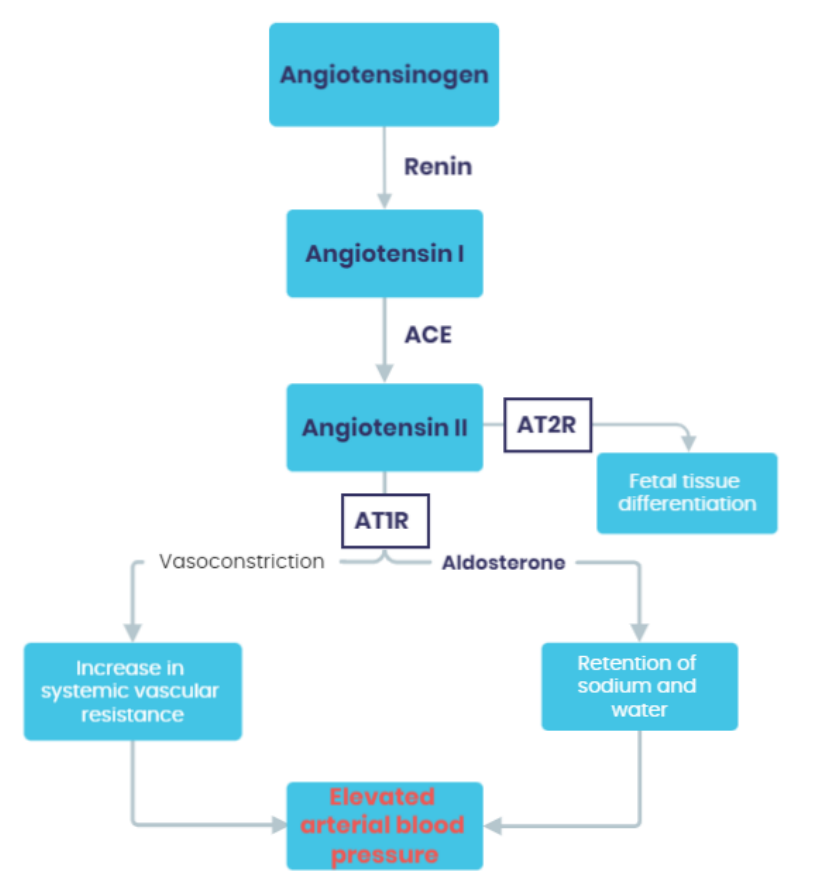
Figure 1. The scheme of the RAAS function. ACE — angiotensin converting enzyme ; AT1R — angio- tensin receptor type 1; AT2R — angiotensin receptors type 2 . receptor type 1; AT2R—angiotensin receptors type